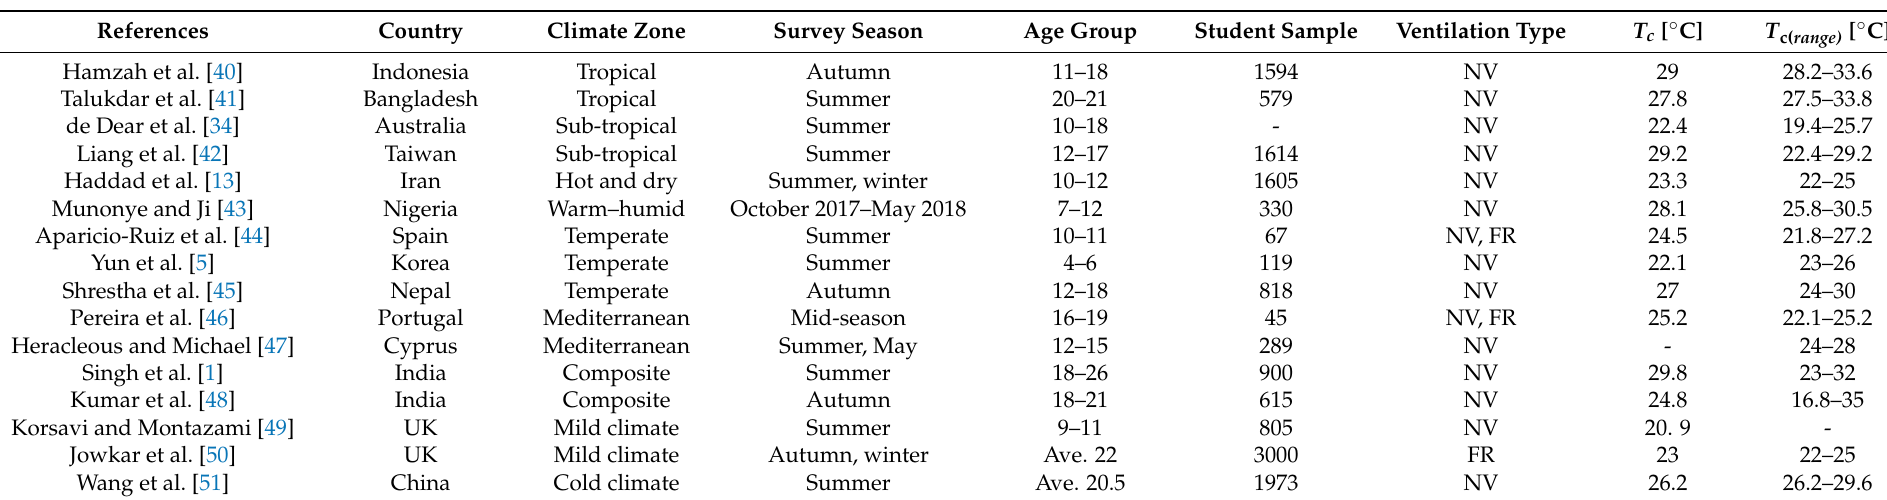
Table 1. Summary of previous thermal comfort research conducted in school/educational buildings with their major findings.